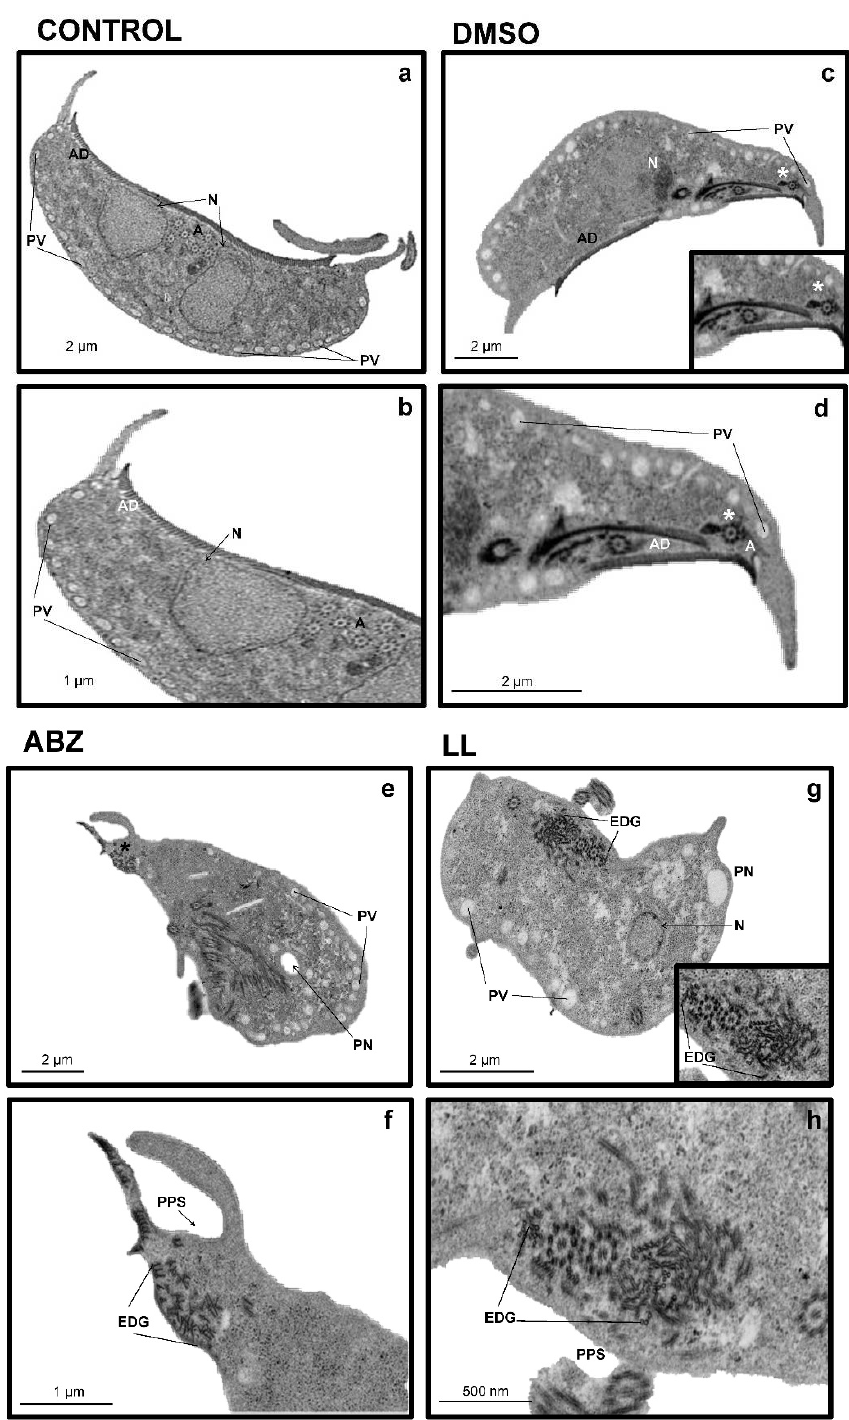
Figure 4. Ultrastructural and necrotic effect of Linearolactone (LL) on G. intestinalis trophozoites. A ) Ultrastructural effect of LL in G. intestinalis trophozoites. Strain WB trophozoites (6000 /mL) were cultured in TY1-S-33 medium ( a , b ) or exposed 40 h/37 ˚C to vehicle cal [0.02% dimethyl sulfoxide (DMSO)] ( c , d ) as negative control, 0.32 µM albendazole (ABZ) as a positive control for damage to the cytoskeleton ( e , f ) and LL the IC 100 ( g , h ) and processed for transmission electron microscopy (TEM). Each panel shows the scale (bar). A: flagellar axonemes; AD: adhesive ventral disc; N: core; PV: peripheral vesicles * AD Fragments; PN: perinuclear space; PPS: periplasmic spaces; EDG : deposited electron-dense granules.